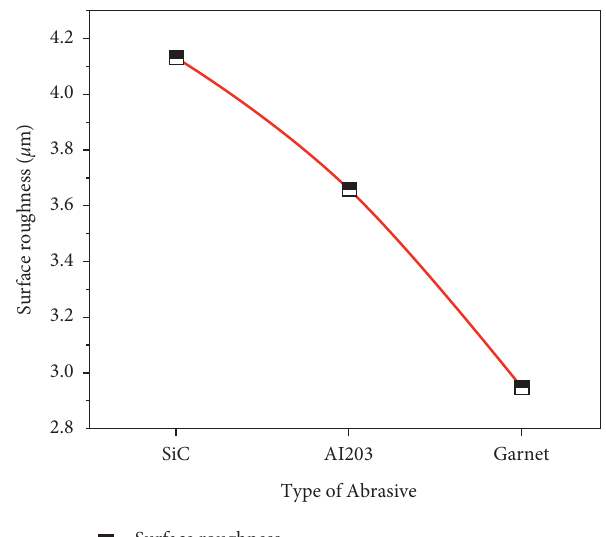
Figure 3: Effect of various abrasives with respect to surface roughness